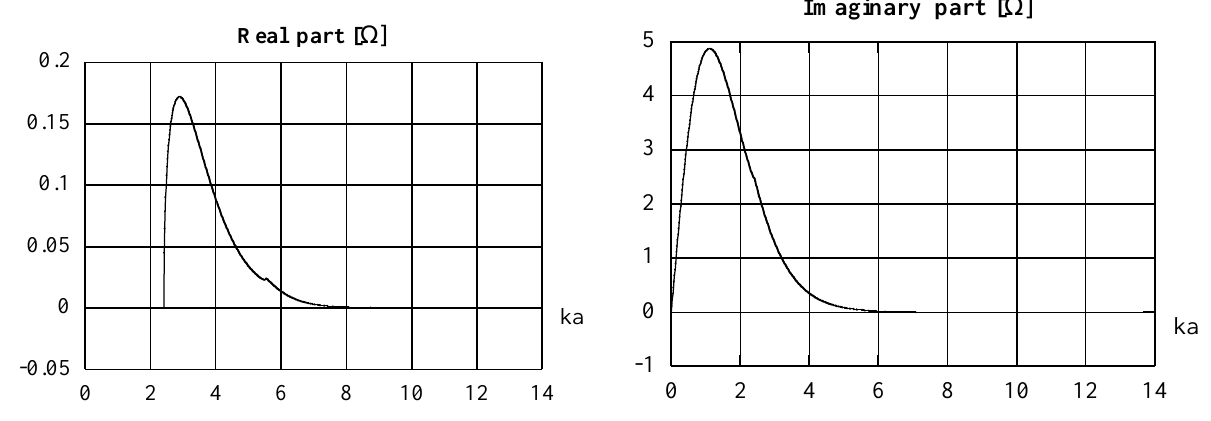
FIG. 12. Real and imaginary parts of the longitudinal coupling impedance in the case (cid:119) (cid:173) (cid:52) (cid:121) (cid:53) and bg (cid:173) (cid:49) .